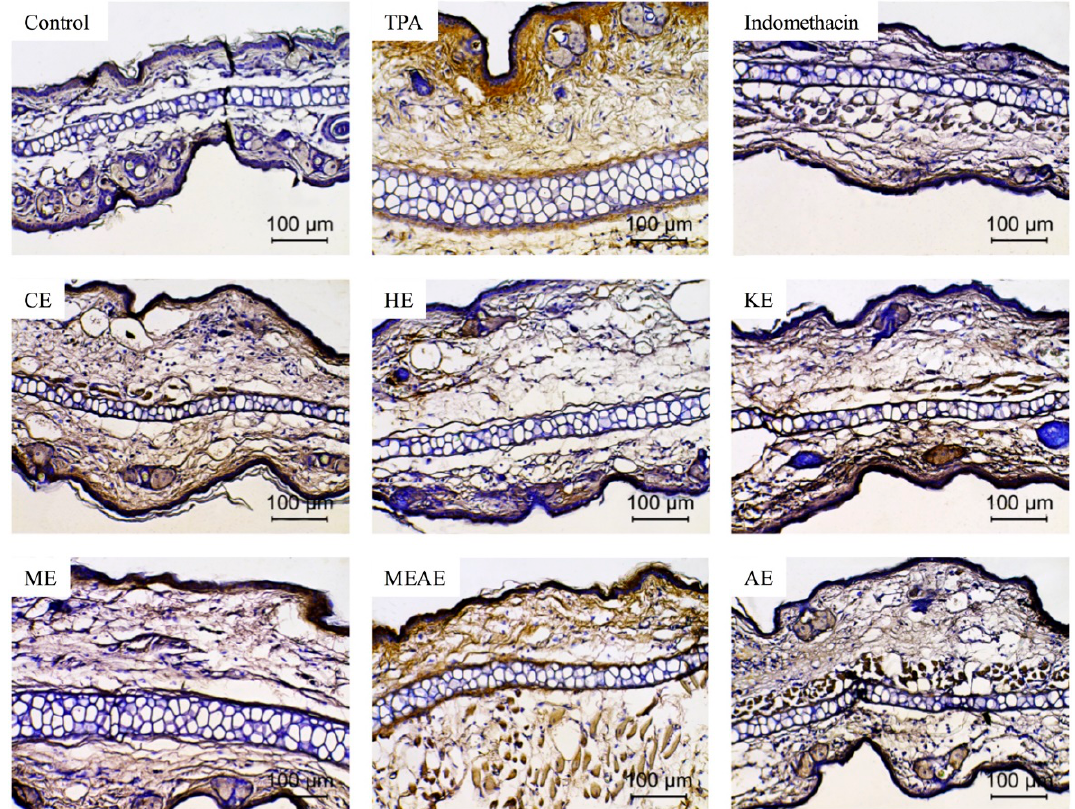
Figure 7. TNF- α expression (golden yellow color) in the mice ear cells due to the effect of different extracts of Acacia farnesiana (AF) pods (3 mg/ear) on the TPA-induced ear edema model (100× magnification). CE = chloroformic extract; HE = hexanic extract; KE = ketonic extract; ME = methanolic extract; MEAE = methanolic:aqueous extract and AE = aqueous